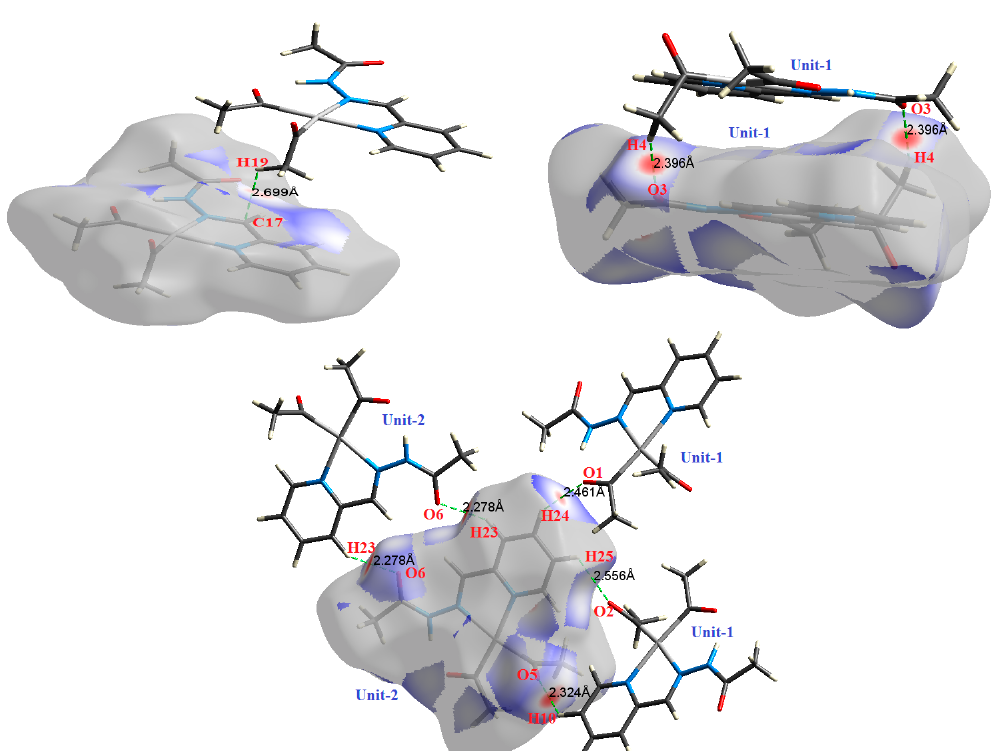
Figure 7. The most important intermolecular contacts in complex 5 .